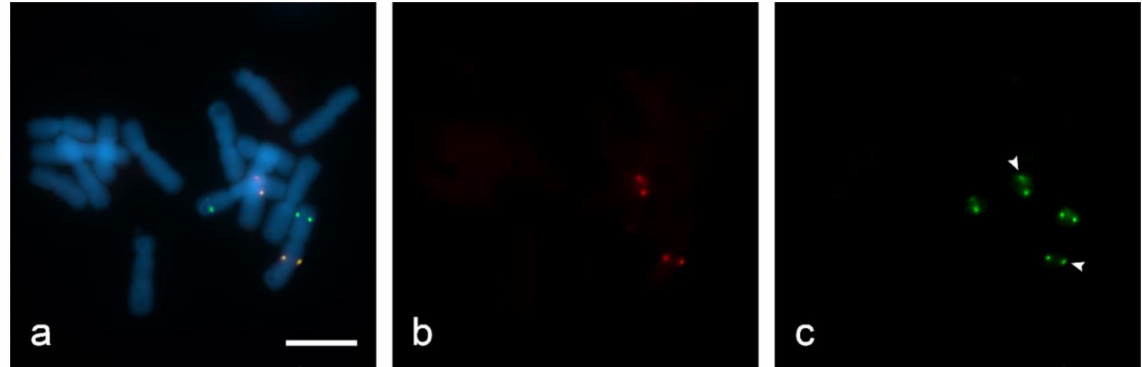
Figure 6. Evaluation of quenching of horseradish peroxidase (HRP) in dual-color sequential Tyr-FISH “SteamDrop” slide. Quenching with 0.3% H 2 O 2 for 30 min: ( a ) visualization of two probes—merged image; ( b ) visualization of Unigene572 detected with tyramide-Cy3 using Cy3-filter (red); ( c ) visualization of Unigene5305 detected with Tyr-FITC using FITC-filter (green), arrows indicate signals arising from Unigene572 because HRP activity after the first detection step was not quenched. Scale bar—10 µ